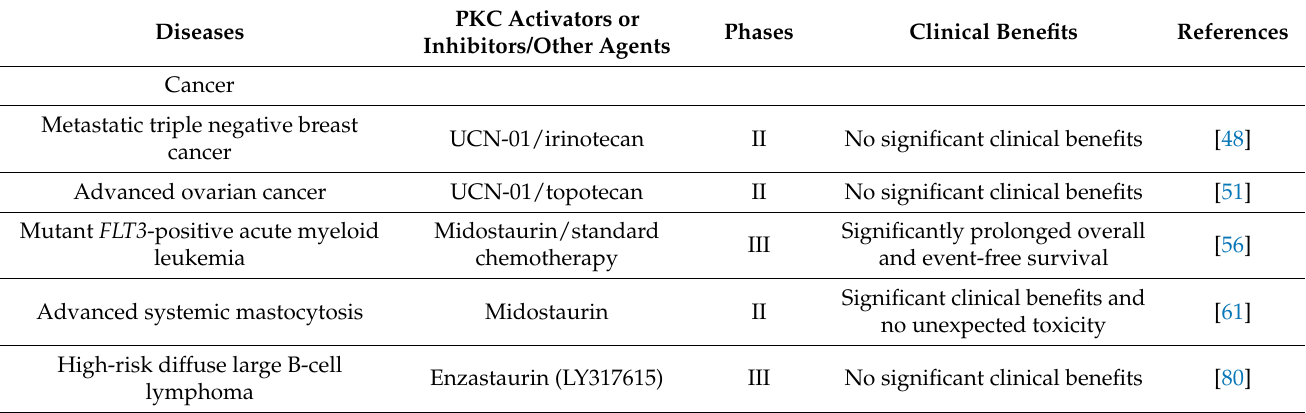
Table 1. Activators and inhibitors of protein kinase C (PKC) and their applications in clinical trials.